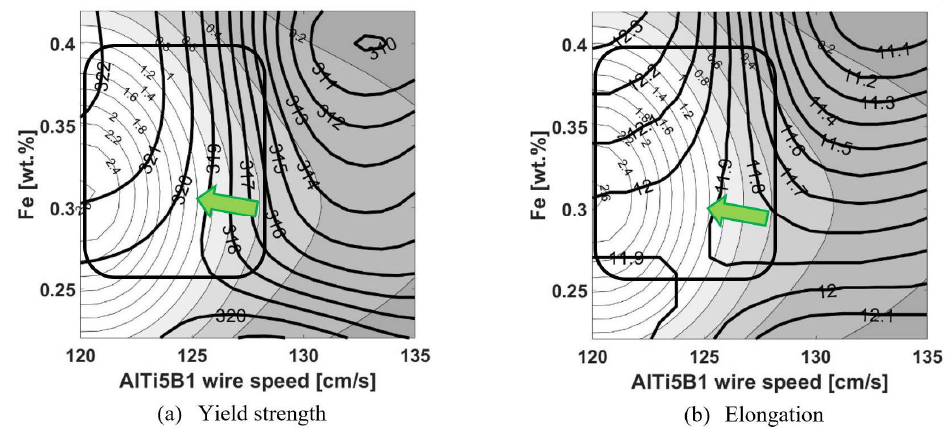
Figure 7. Common influence of the rate of AlTi 5 B1 wire addition and casting temperature on ( a ) yield strength and ( b ) elongation. Green (grey) arrows indicate increase of the observed mechanical property.